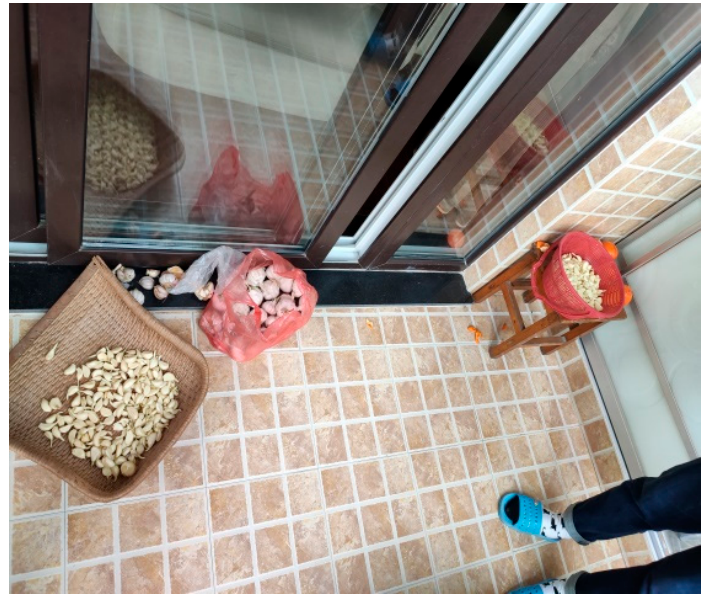
Figure 1. Combustibles on the balcony.